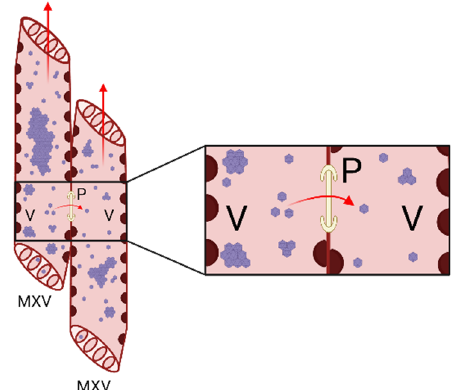
Figure 4. A model shows virus moment between two adjacent mature xylem cells. The mature xylem cells are connected by porous pits, which viruses can potentially use to move through. The red arrows indicate the virus translocation route. MXV: matured xylem vessel; V: virus; P: pit. Figures was created with Biorender.com.